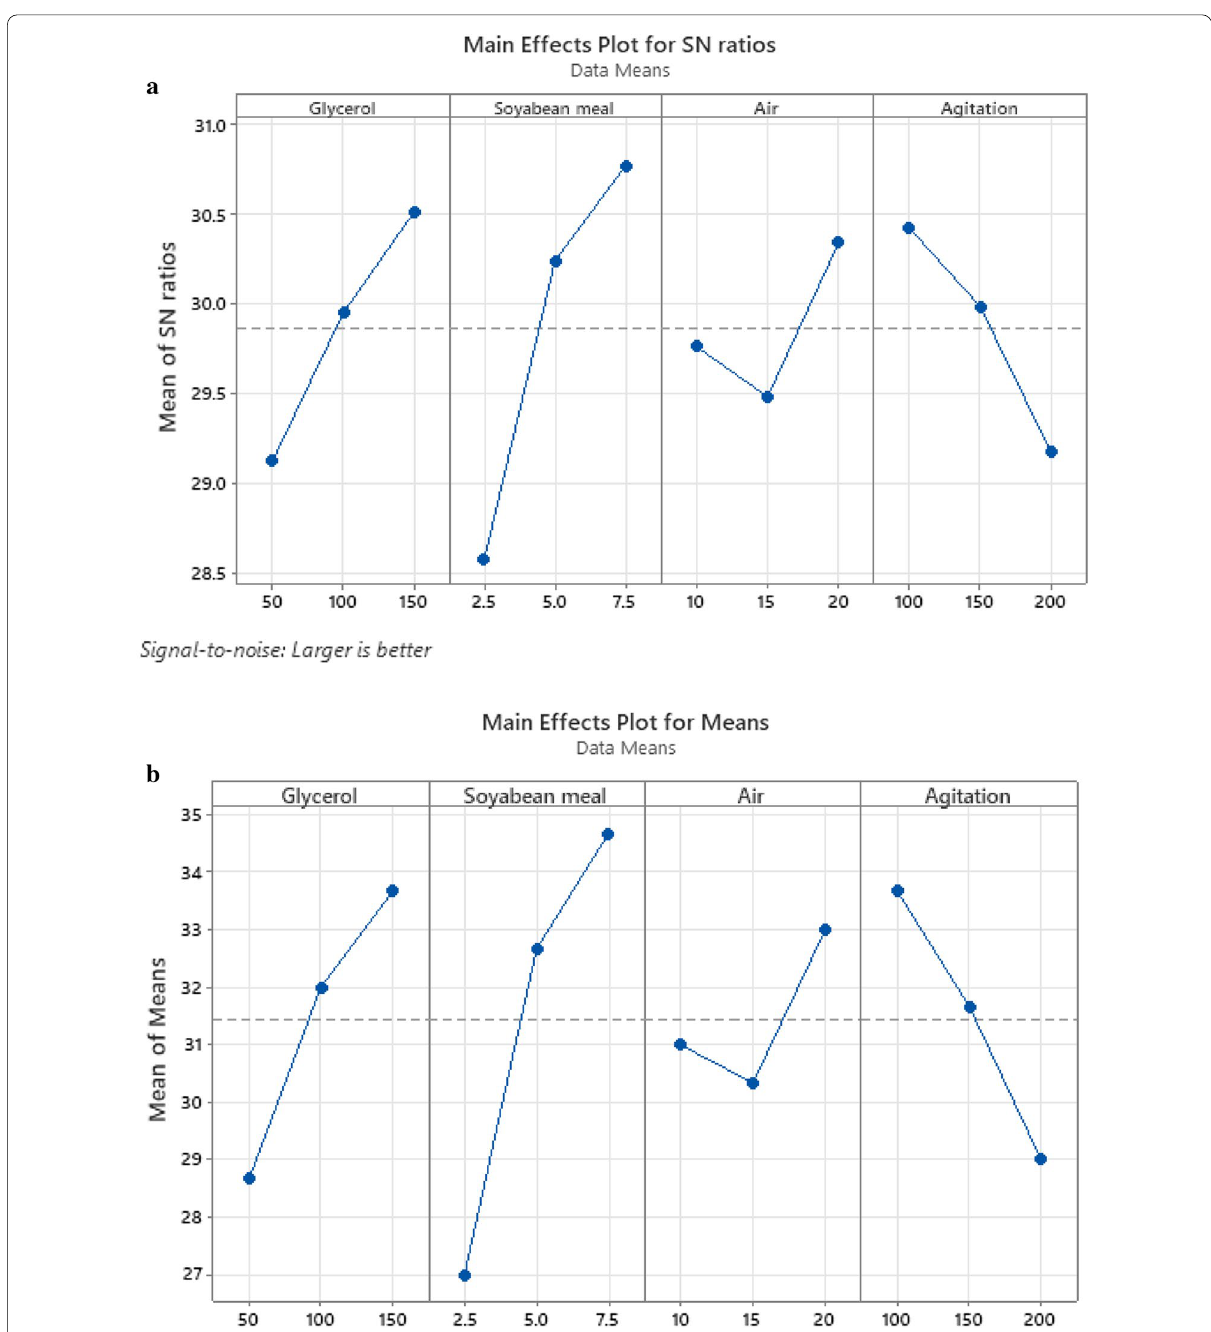
Fig. 4 Main effects plot for Biomass (DCW) and Setomimycin production by Streptomyces sp. RA-WS2 ( a ) S/N ratio for Biomass (DCW) ( b ) Means for Biomass (DCW) ( c ) S/N ratio for Setomimycin ( d ) Means for Setomimycin